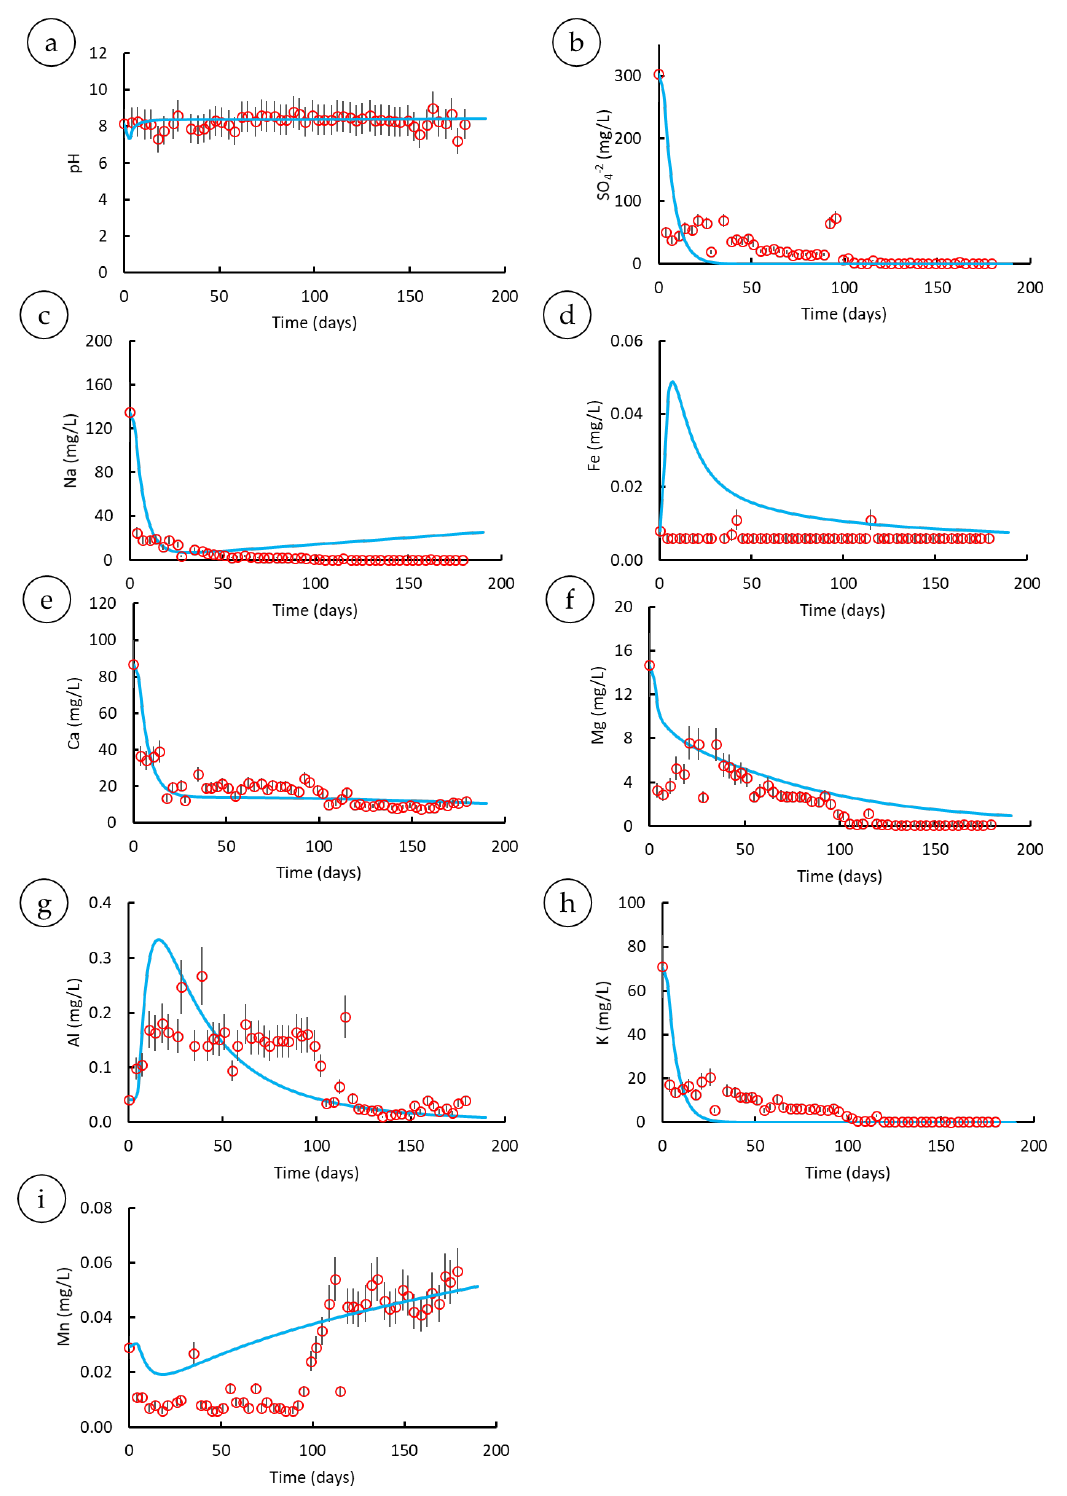
Figure 8. Weathering cell test T1 and PHREEQC modeling results. ( a ) Experimental and simulated results of the pH. ( b ) Experimental and simulated results of sulfate. ( c ) Experimental and simulated results of sodium. ( d ) Experimental and simulated results of the total dissolved iron. ( e ) Experimental and simulated results of total dissolved calcium. ( f ) Experimental and simulated results of total dissolved magnesium. ( g ) Experimental and simulated results of total dissolved aluminum. ( h ) Experimental and simulated results of total dissolved potassium. ( i ) Experimental and simulated results of total dissolved manganese.